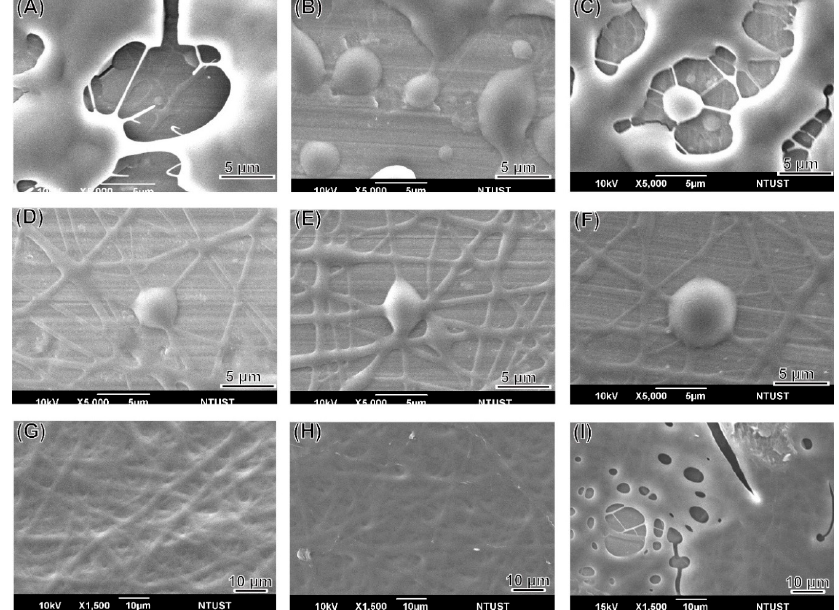
Figure 1. SEM images of the blank polyvinylpyrrolidone (PVP)/poly(methylmethacrylate) (PMMA) microparticle produced from ( a – c ) in the Ace/DMF = 1/2 cosolvent system; ( d – f ) in the Ace/DMF = 1/1 cosolvent system; ( g – i ) in the Ace/DMF = 2/1 cosolvent system. Polymers 2020 , 12 , x FOR PEER REVIEW